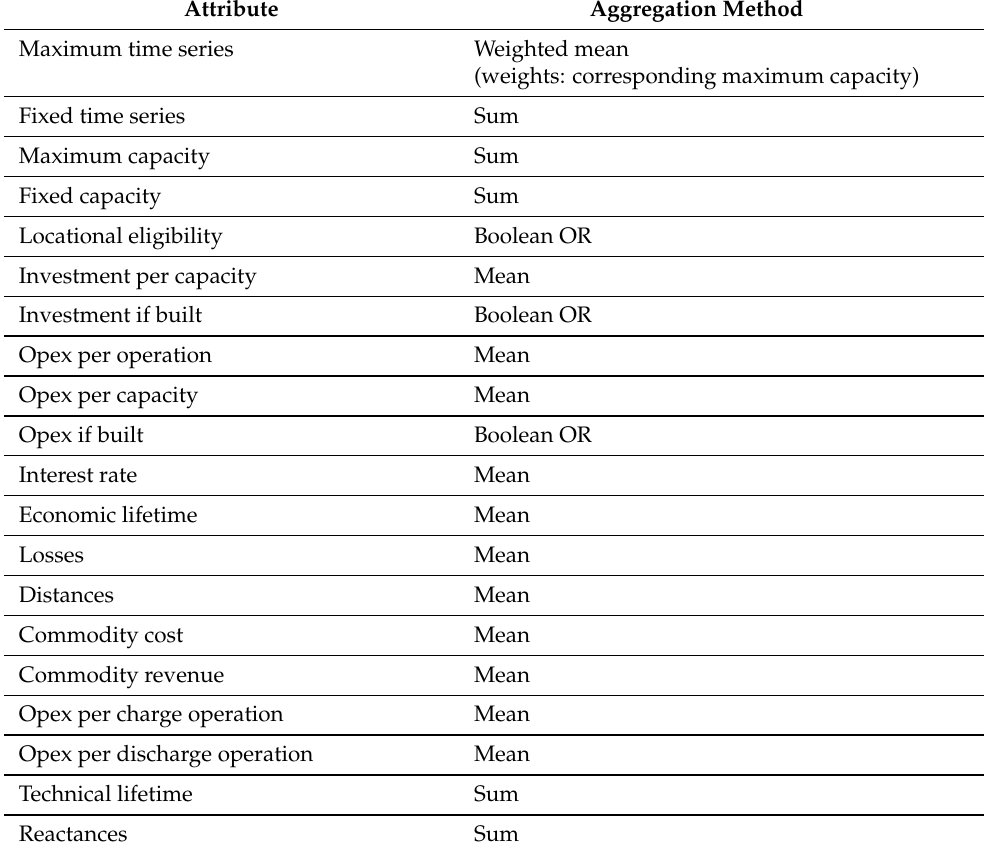
Table 4. Aggregation method employed for each data